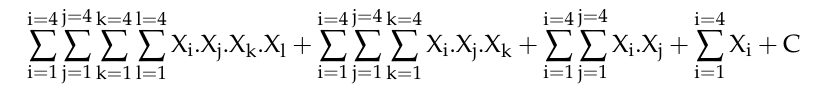
Figure 5. Relative importance of input parameters.